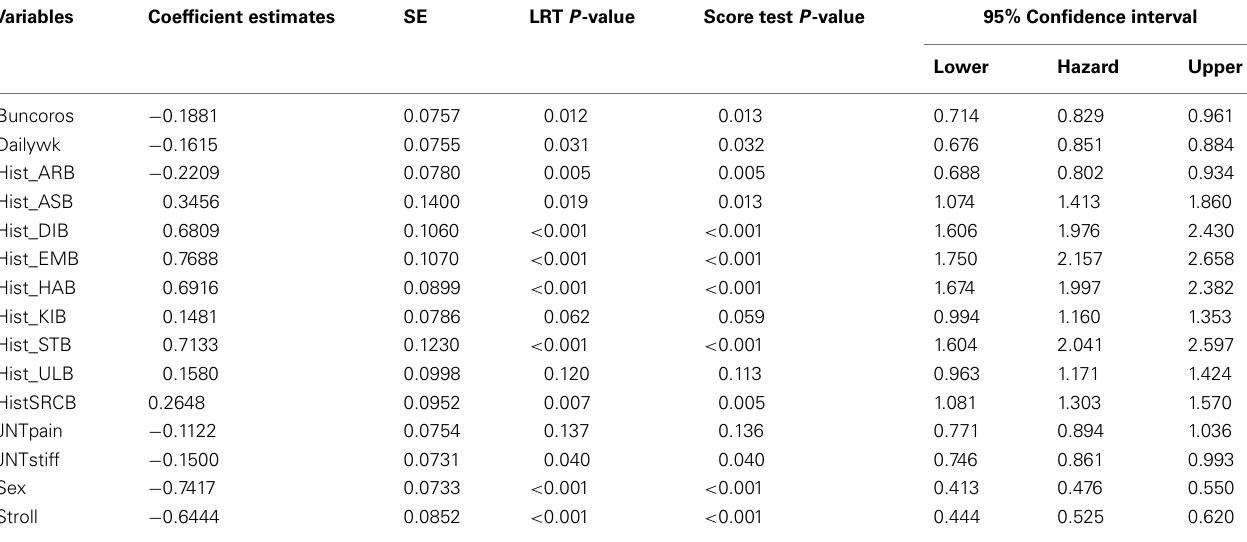
Table 2 | Stratified univariate analysis for daily walking data using Cox regression model.